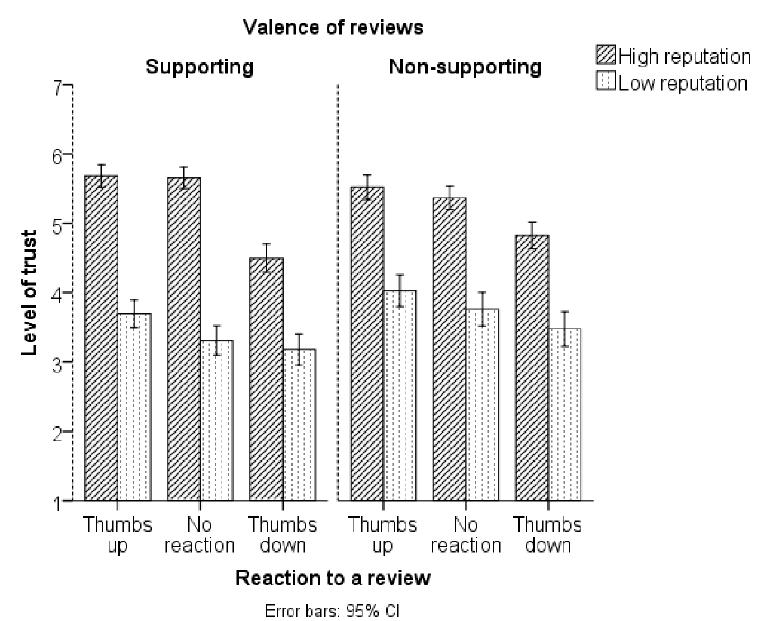
Figure 6. E ff ect of reaction to a review, reputation score and valence of reviews on level of trust.